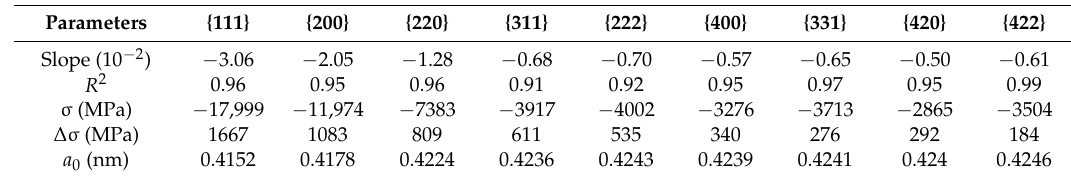
Figure 4. The a { hkl } vs. sin 2 ψ plots for various lattice planes of TiN calculated under the { hkl } mode. Table 3. Results of calculations at the { hkl } mode.